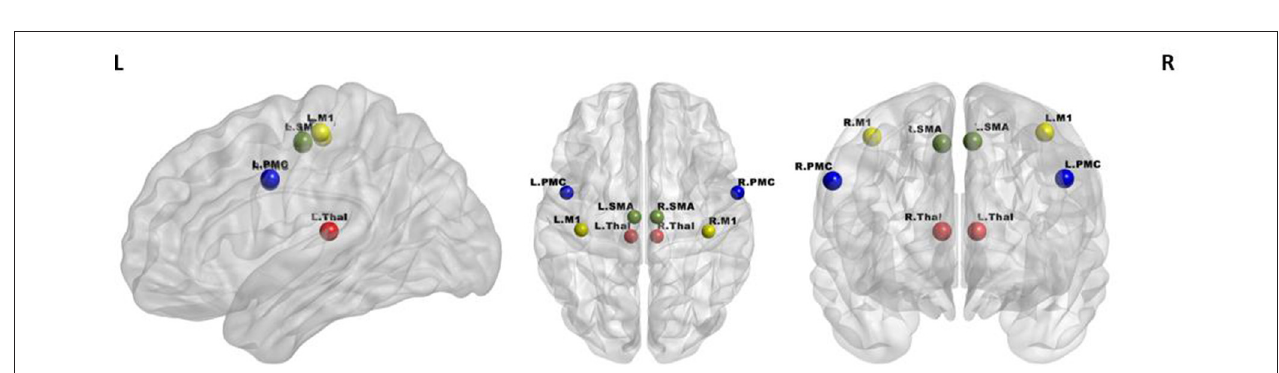
thalamus, and lateral premotor cortex (PMC) in the right and left hemispheres, as illustrated in Figure 3 using BrainNet Viewer (Xia et al., 2013) and abbreviated as per Table 3 . The MNI coordinates, also specified in Table 3 , for the eight regions were used to create 8-mm spherical seeds. For each subject, BOLD